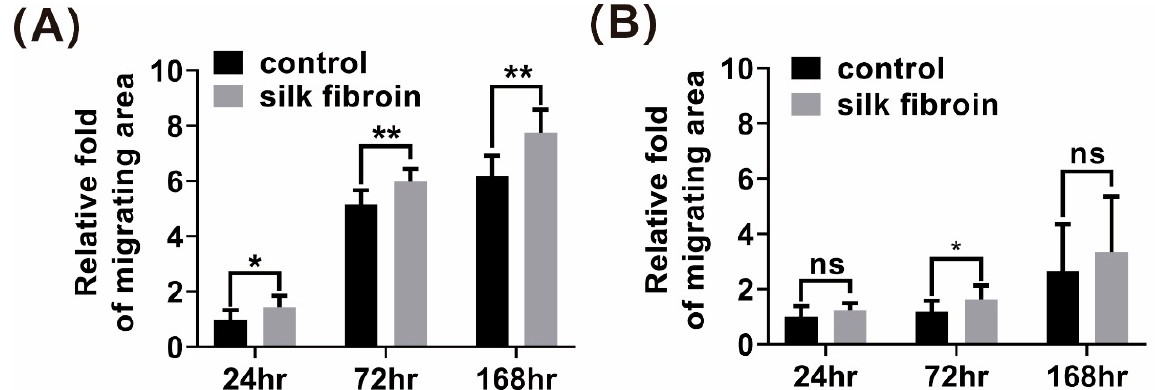
Figure 4. Influence of β -sheet silk fibroin on in vitro cell migration, expressed as the relative fold change in the migrating area of ( A ) human dermal fibroblasts and ( B ) HaCaT keratinocytes. Data are presented as the mean ± standard error of the mean ( n = 4; * p < 0.05, ** p < 0.01, ns: not significant).